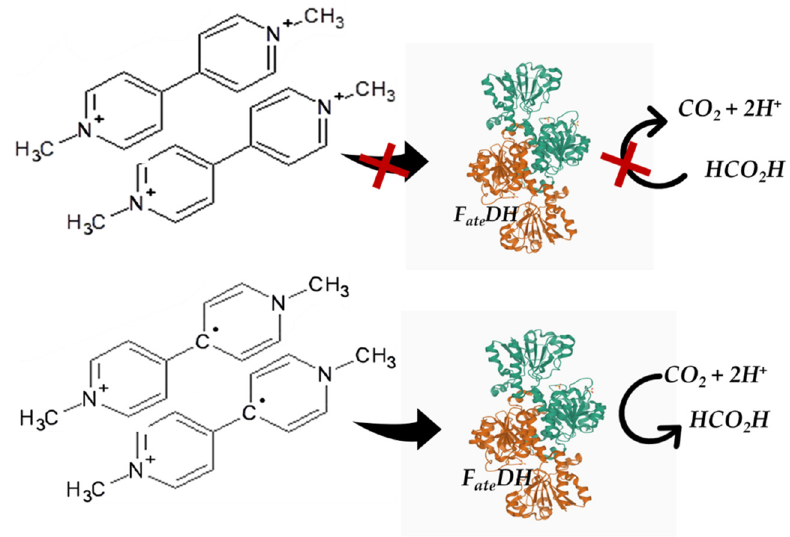
Figure 6. CO 2 to formic acid conversion using an MV 2+ cofactor